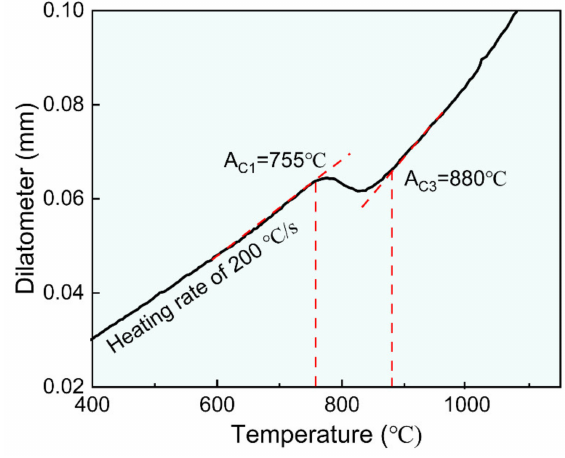
Figure 2. A typical dilatometer curve of the experimental steel.